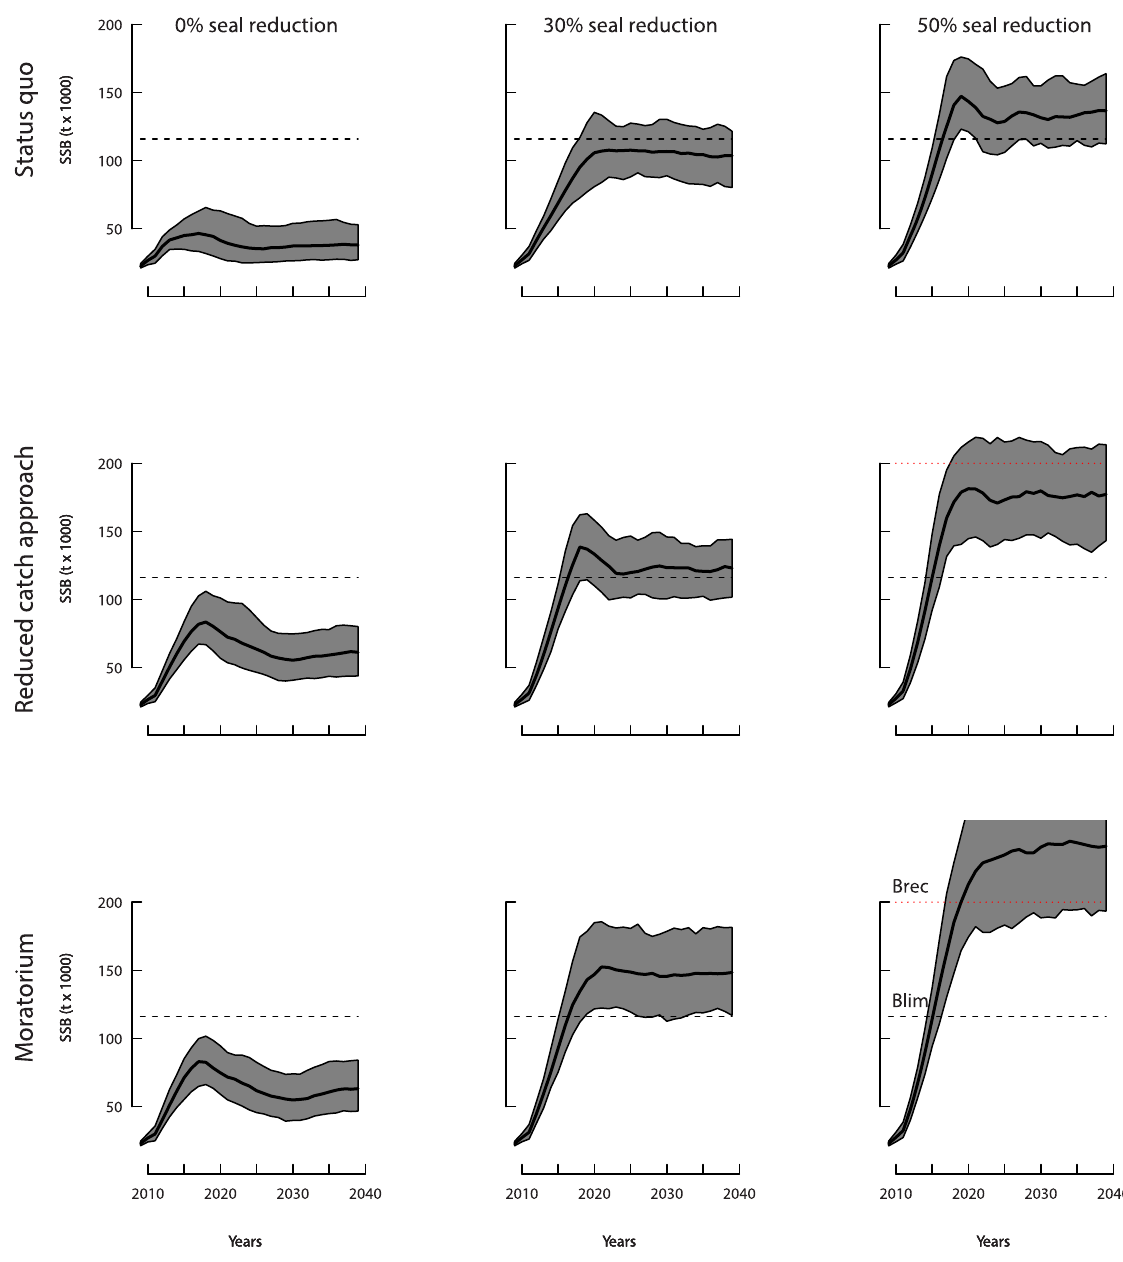
Figure 5. Cod SSB forecast in years 2010–2040 under water warming conditions (cold intermediate layer (CIL) anomaly =0.75 u C). Plain lines and grey areas indicate median values and 90%-confidence domains, respectively. The dashed line indicate the limit of recruitment overfishing B lim . The red dotted line indicates the complete recovery point B rec .